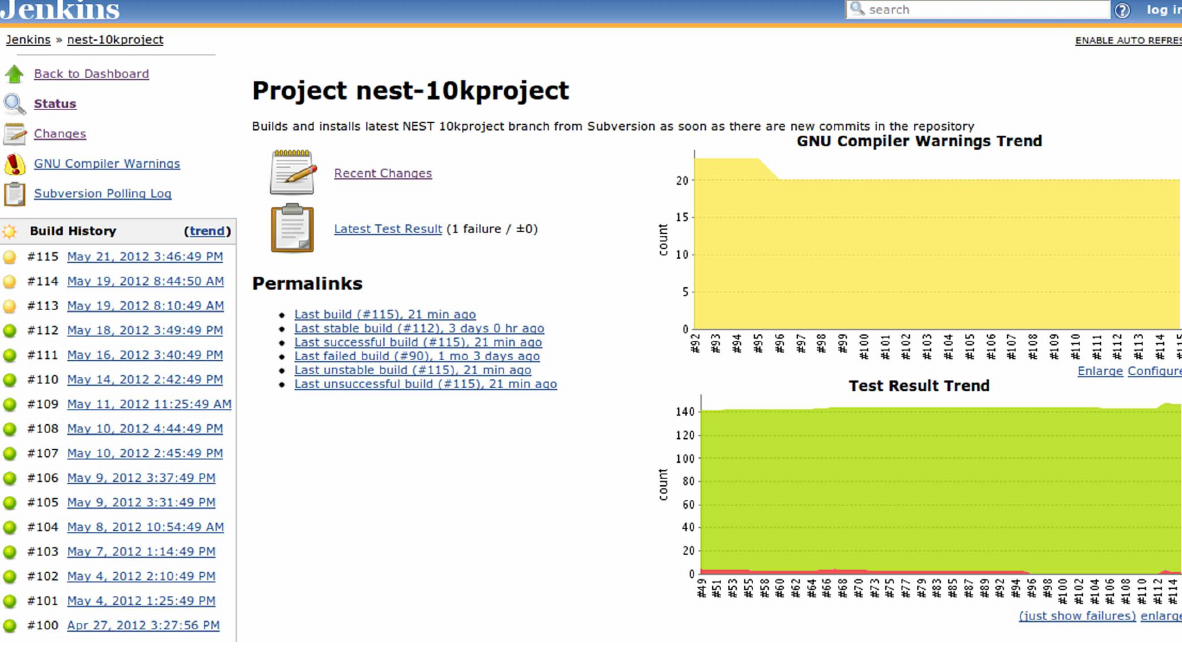
FIGURE 4 | Jenkins build job view featuring the build job set up specifically for the “10K Project” branch mentioned in the main text (section 3.2.1). The build history bar on the left side shows the outcomes of the recent builds and provides links to the detailed information, i.e., which changes triggered the build, detailed build log, etc. Additionally two trend